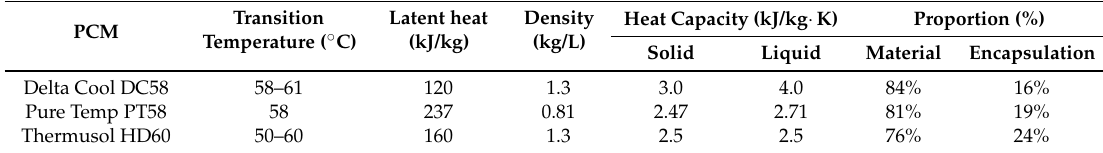
Table 1. PCM thermophysical properties and material-encapsulation proportion.